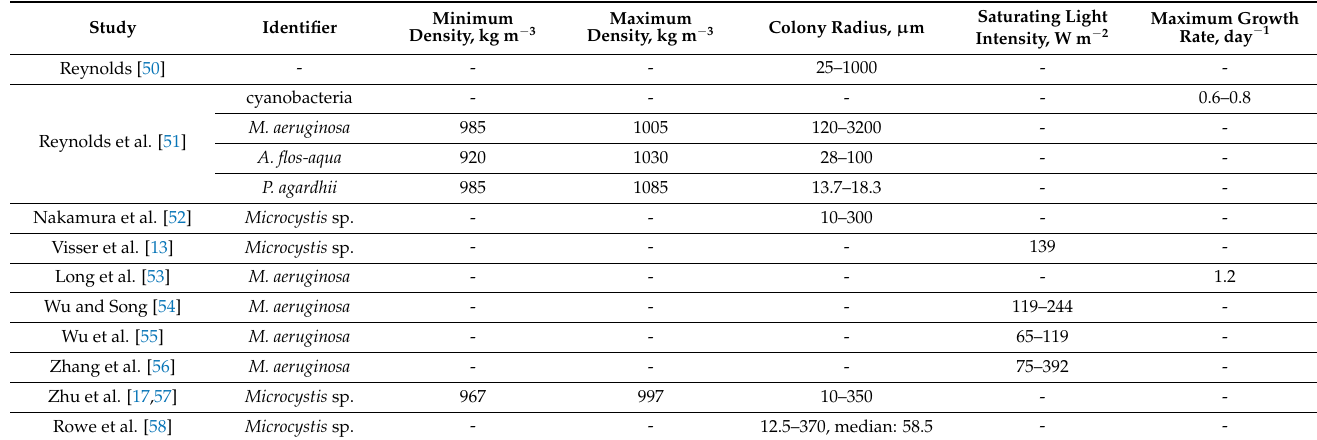
Table 2. Literature values for biological parameters of cyanobacteria used in models.